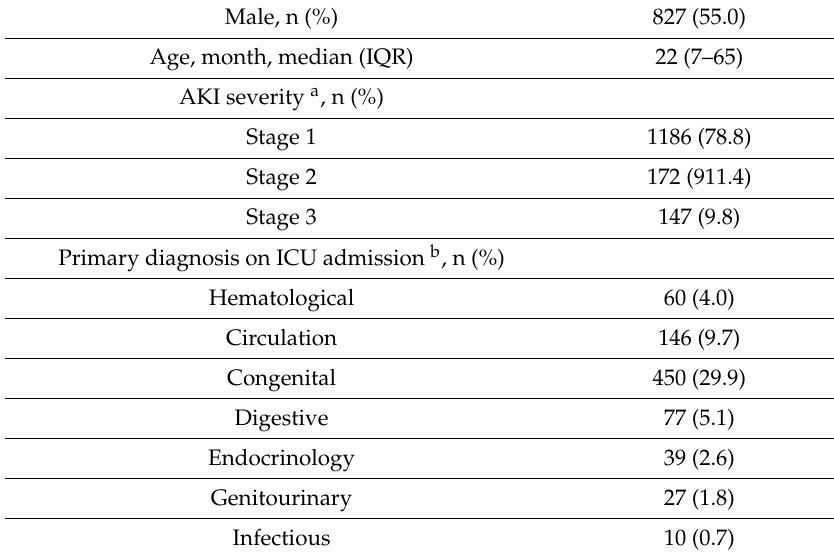
Table 1. Baseline characteristics of children admitted to intensive care unit (N =